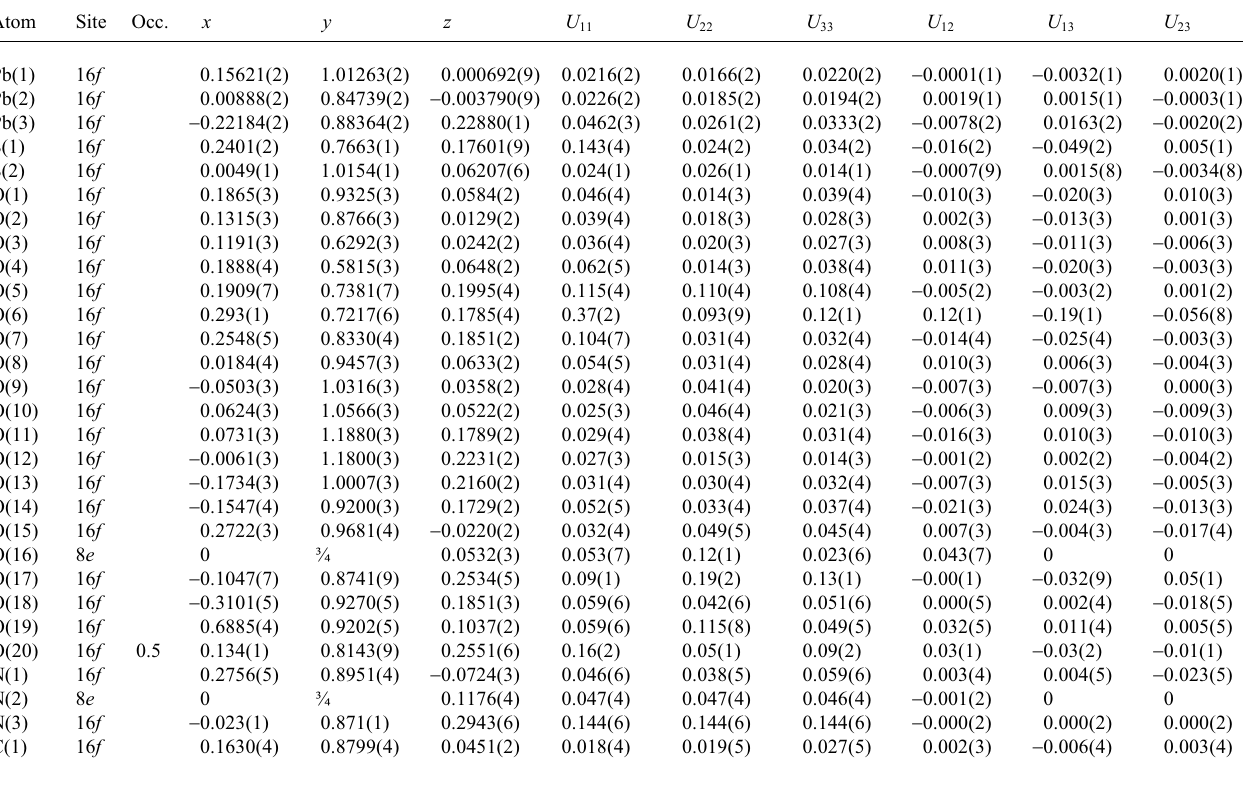
Table 3. Atomic coordinates and displacement parameters (in Å 2 ) .